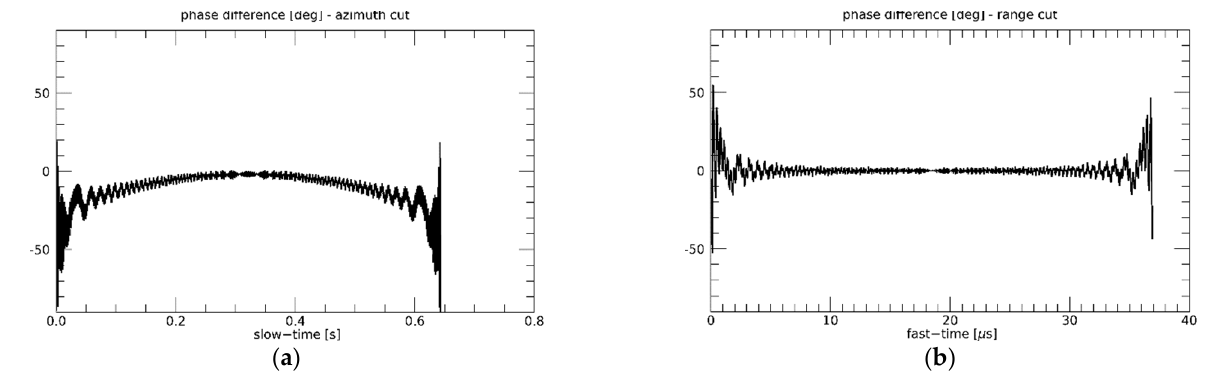
Figure 8. One-stationary configuration. Slow-time ( a ) and fast-time ( b ) cuts of the difference between the phases of the raw signals simulated in time and frequency domains.